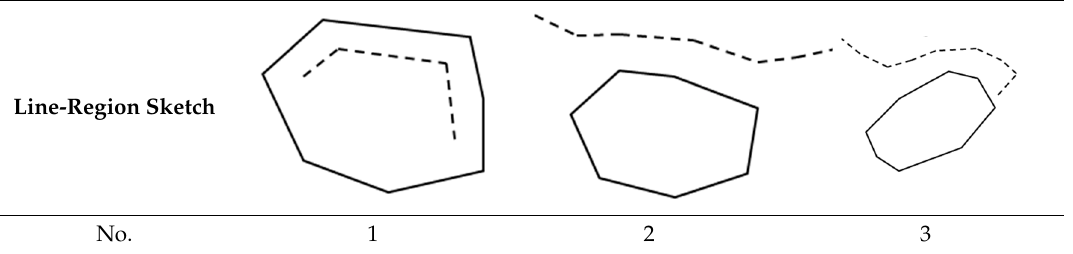
Table 7. Examples of line-region sketches and classification